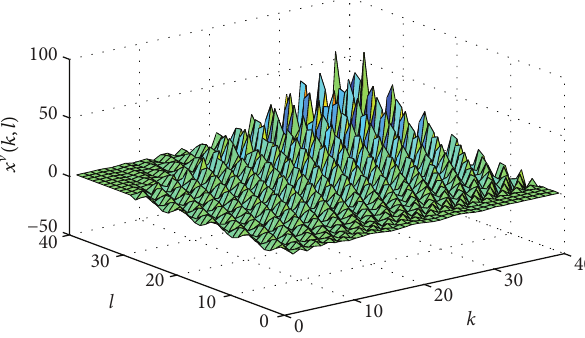
Figure 6: The state trajectory of 𝑥 V (𝑘, 𝑙) with 𝑎 2 = −8.9